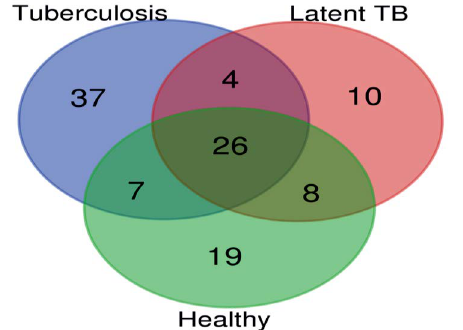
Fig. 2. A venn diagram showing total proteins identified in at least one individual from each group of Tuberculosis, Latent TB and Healthy. Numbers of identified proteins are shown in different overlaps between